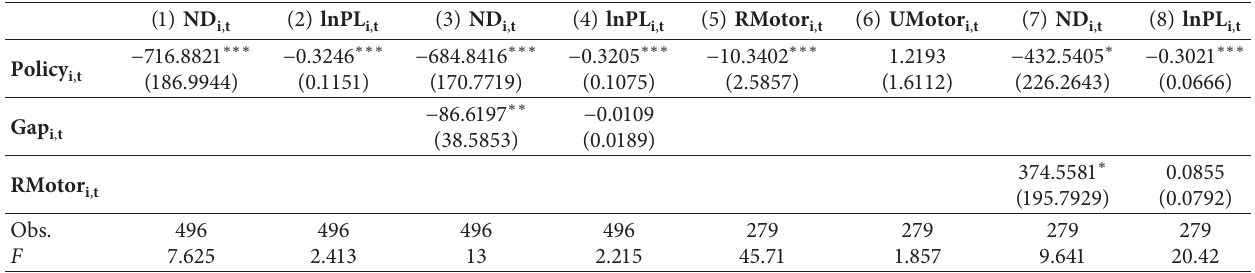
Table 9: The effect of provincial motorcycle bans on freeways on traffic accidents.